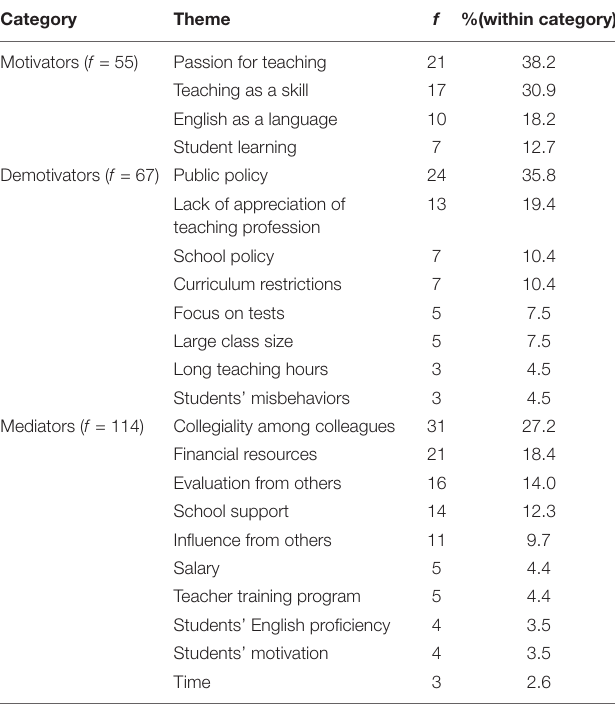
TABLE 3 | Results of qualitative analysis of interview